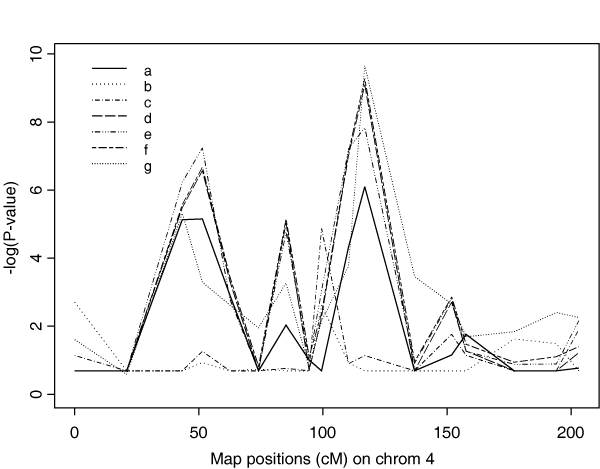
Two-point linkage analysis. The y-axis shows the negative of the natural logarithm of p-values. Curves a, b, and c are from SOLAR for ecb21, ttth1, and ttth2 data, respectively. Curve d is from our model with a constant s(t) using both ecb21 and ttth1. Curves e and f are for ecb21, ttth1 and ttth2 together, where both assume s(t) as a constant function; e assumes the same environmental covariance between any two phenotypes and f assumes different environmental covariance between any two phenotypes. Curve g is for ecb21, ttth1, and ttth2 together, assuming s(t) as a linear function and different environmental covariance between any two phenotypes.